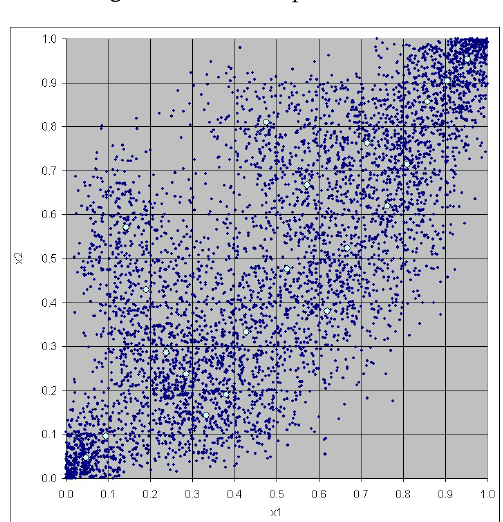
Figure 22. NB UF copula, a = 15.